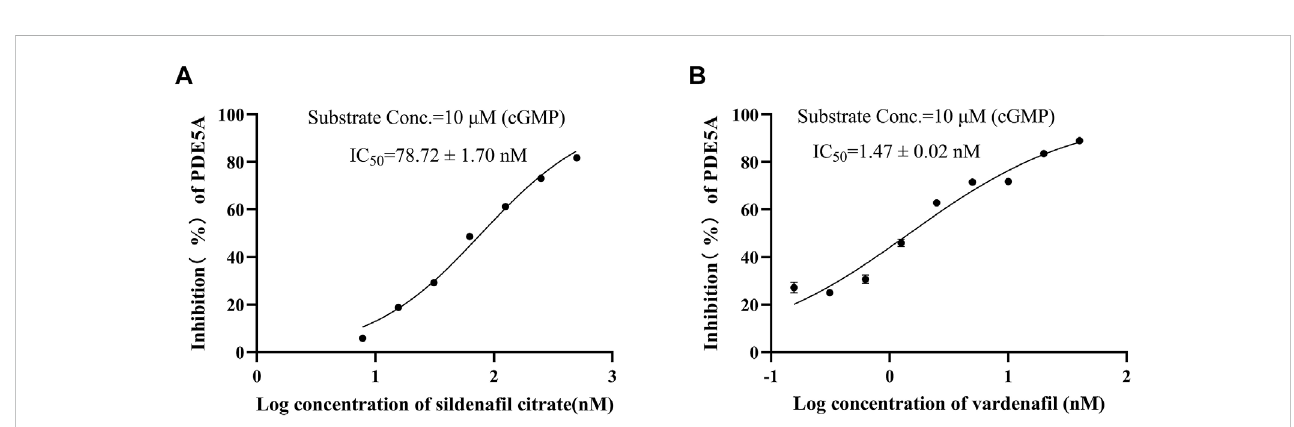
FIGURE 4 Positive drug inhibitory activity results were detected by LC/MS strategy. (A) Inhibitory activity of sildena fi l citrate on PDE5A. (B) Inhibitory activity of vardena fi l on PDE5A.